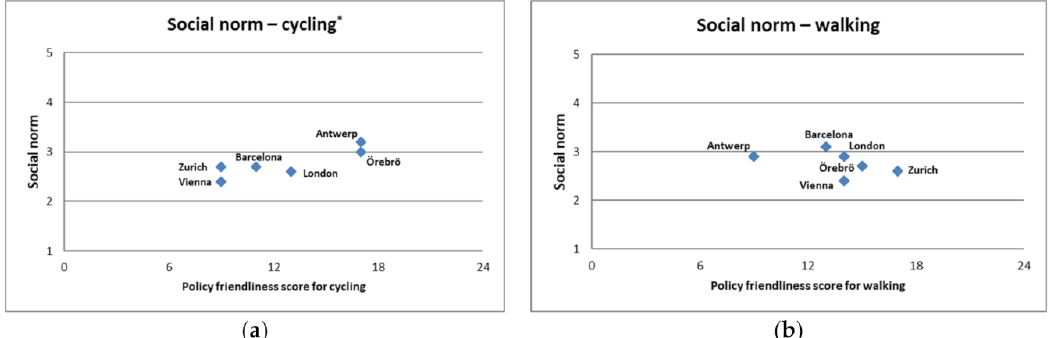
Figure 2. Correlation of the scoring of the policy friendliness score with the social norms, measured as average of two questions in the PASTA baseline questionnaire (“People who are important to me think I should walk/cycle more” and “In my neighborhood, walking/cycling is well regarded”, each applying a 5-point answering scale from “very much agree” to “very much disagree”). * = p < 0.05. ( a ) Correlation between social norm and policy friendliness score on cycling (r = 0.890, p = 0.008 *); ( b ) Correlation between social norm and the policy friendliness score on walking (r = − 0.259, p =